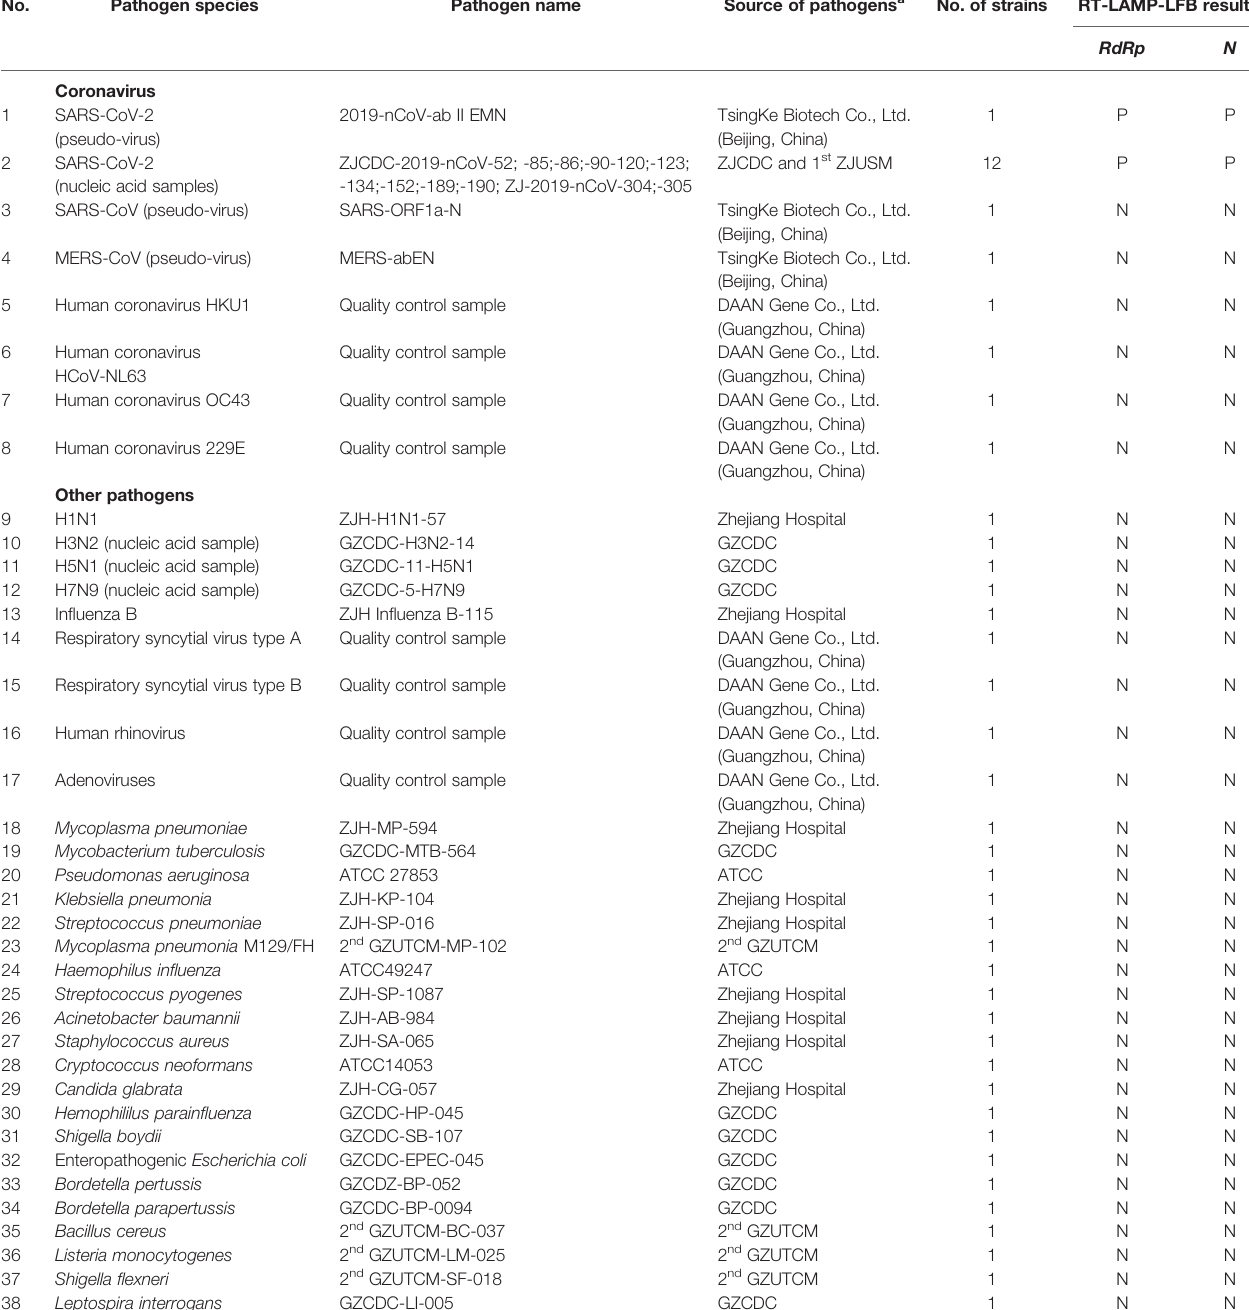
TABLE 2 | Pathogens used in the current study.